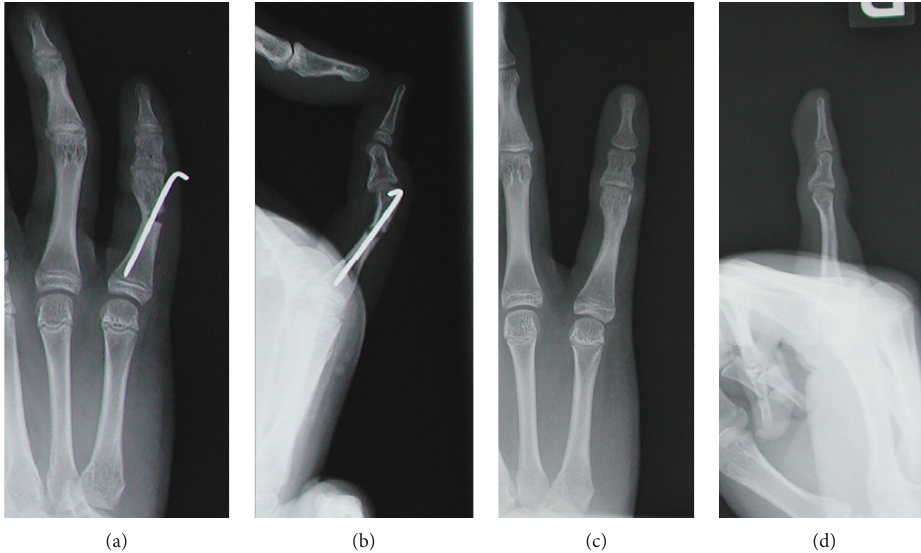
Figure 5: Postoperative radiographs of Case 1. (a, b) Images taken immediately after the surgery. (c, d) Images taken 1 year postoperatively.